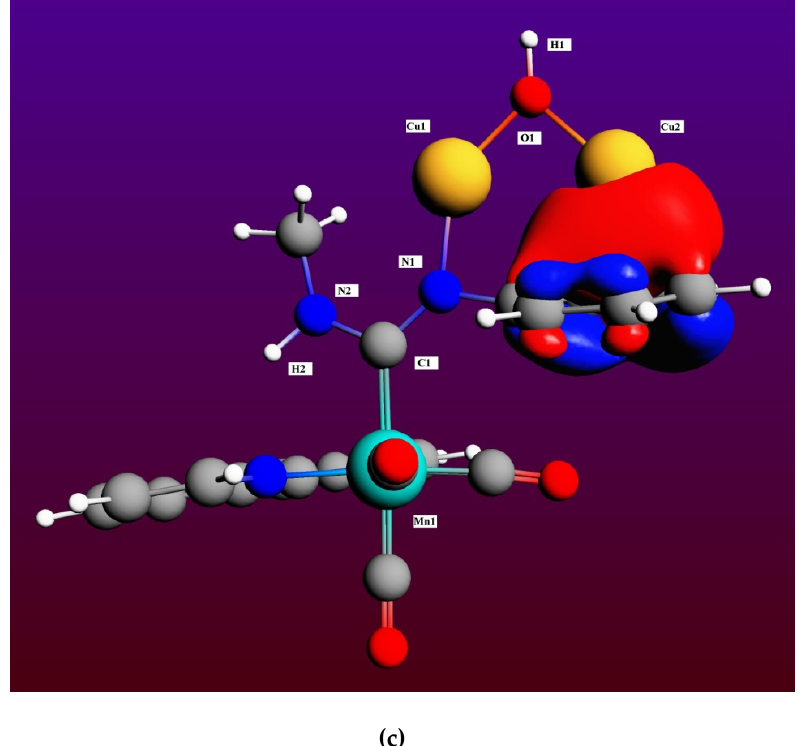
Figure 7. Representation of the canonical HOMO molecular orbital of intermediates I3 ( a ) and I8 ( b ), showing the contributions from different atoms, and the Boys-Foster localized molecular orbital accounting for the Cu2-phenyl group interaction in I8 ( c ). Color codes: Mn (cyan), C (dark grey), O (red), N (dark blue), H (white), Ag (light grey), and Cu (orange).